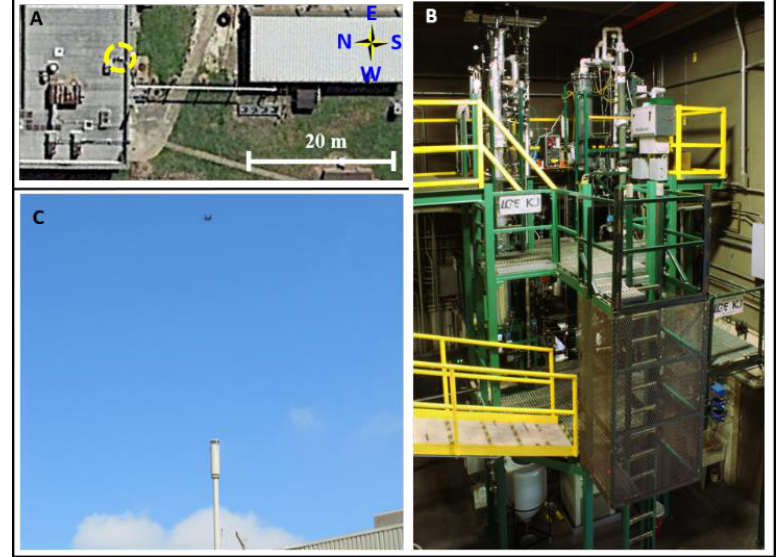
Figure 1. ( A ) Aerial view of the facilities employed in the University of Kentucky Center for Applied Energy (UKy-CAER). The coal flue gas generator is located to the right side and the gas flows through a polyvinyl chloride (PVC) pipe (from right to left) to the building on the left-hand side for amine treatment in the carbon capture system (CCS) before the scrubbed flue gas emissions are released out the stack at the top (yellow dashed circle). ( B ) Image of the amine-based CCS at UKy-CAER. ( C ) Perspective view of the small unmanned aerial system (sUAS) flying above the stack.